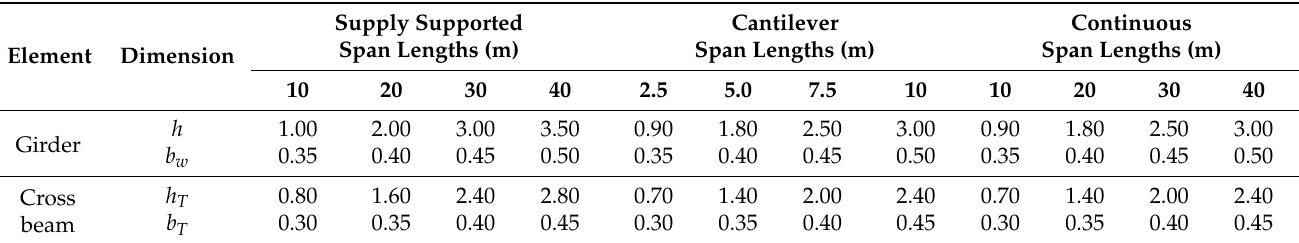
Table 2. Dimensions of the structural elements.